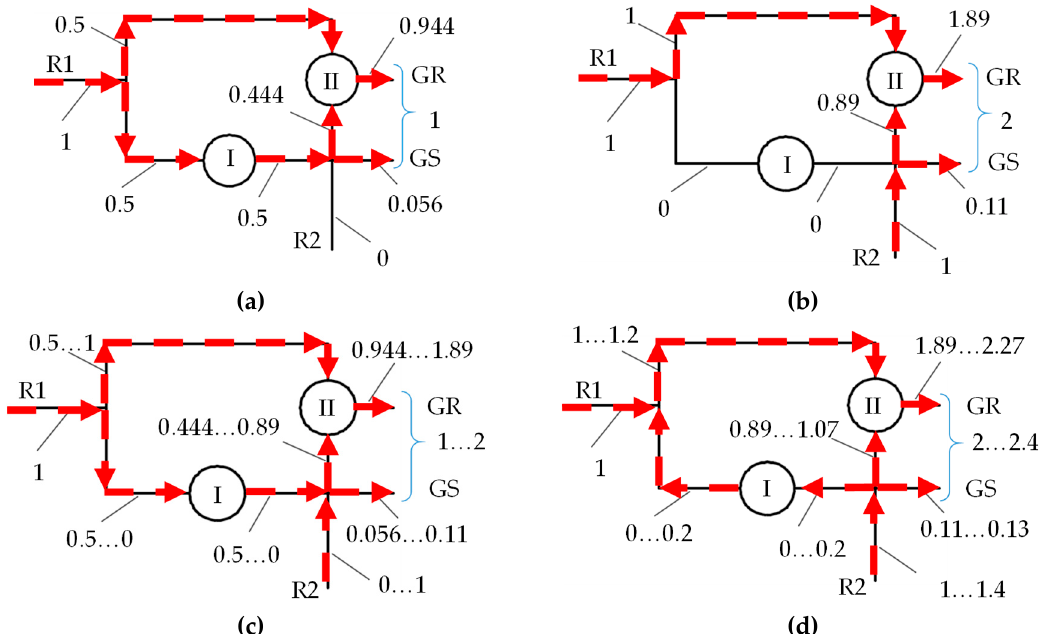
Figure 6. Power flow in the premise of neglecting friction for the case: ( a ) k t = 0 ; ( b ) k t = 1, ( c ) 0 < k t < 1; ( d ) k t ≥ 1.